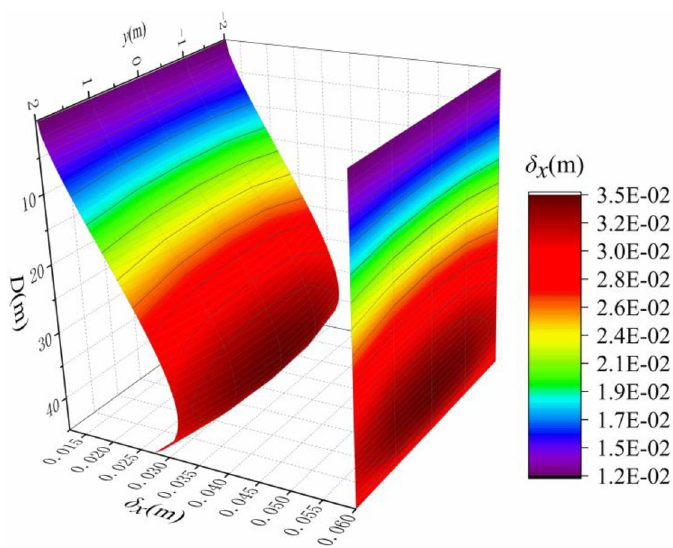
Figure 13. Horizontal displacement at different distances from the centerline of the